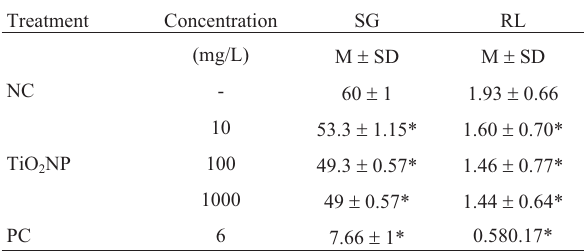
Table 3 - Chromosome aberration (CA) types observed in meristematic cells of A. cepa exposed to titanium dioxide nanoparticles (TiO 2 NP).